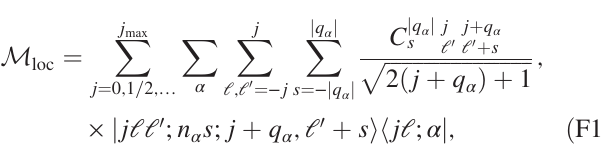
FIG. 14. (a) Schematic representation of M the reduced basis to the full one. Different line styles are used to indicate the different spaces where